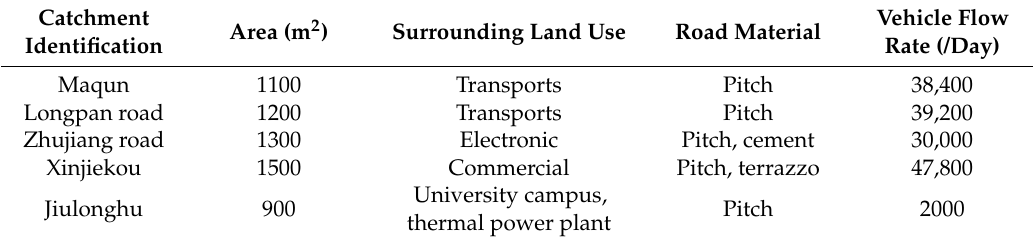
Table 1. Characteristics of studied catchments.